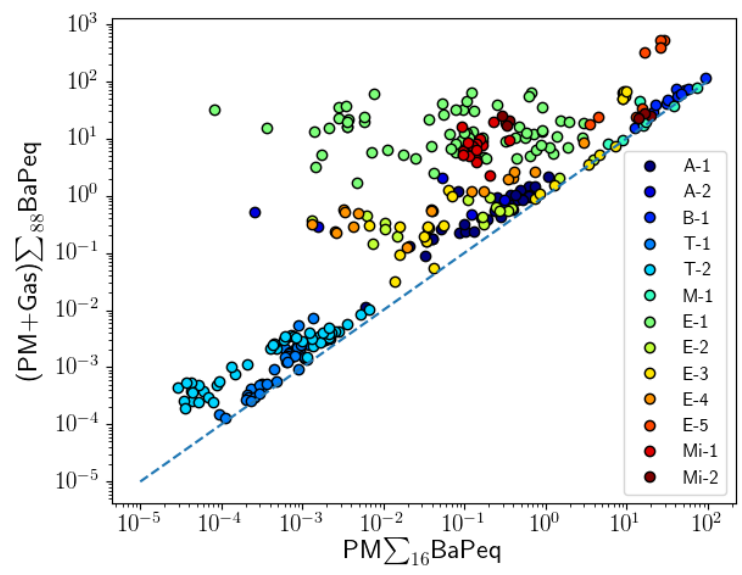
Figure 6. BaPeq correlation between 16 EPA particle-phase PAHs and 88 PAHs in both gas and particle phases.